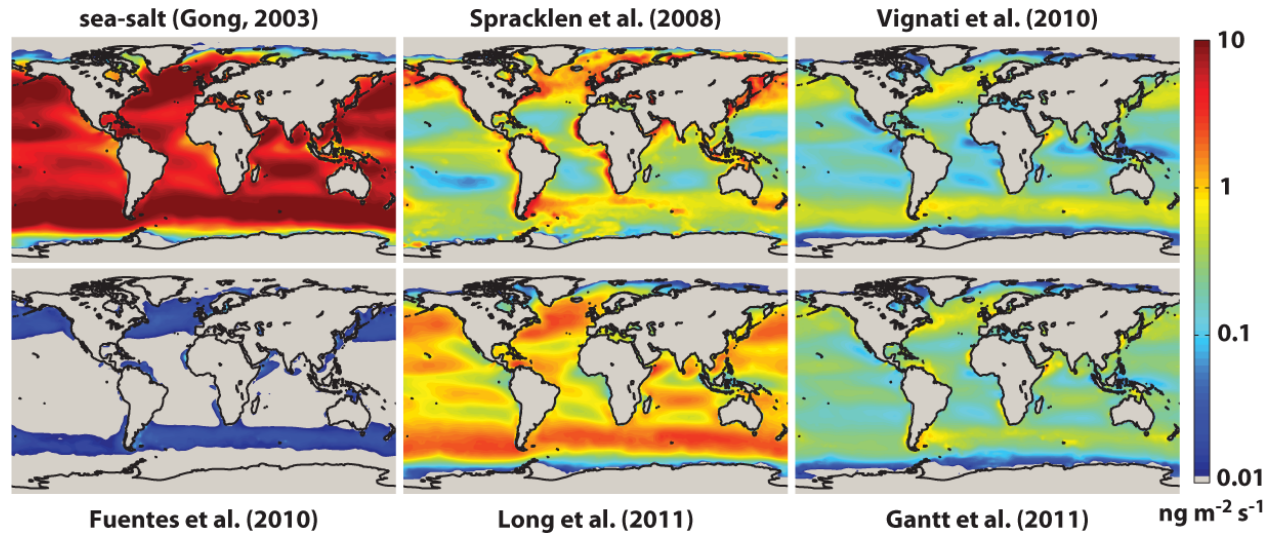
Fig. 1. Annual average submicron emissions in units ofngm − 2 s − 1 of sea-salt (Gong, 2003) and marine POA from the five emission